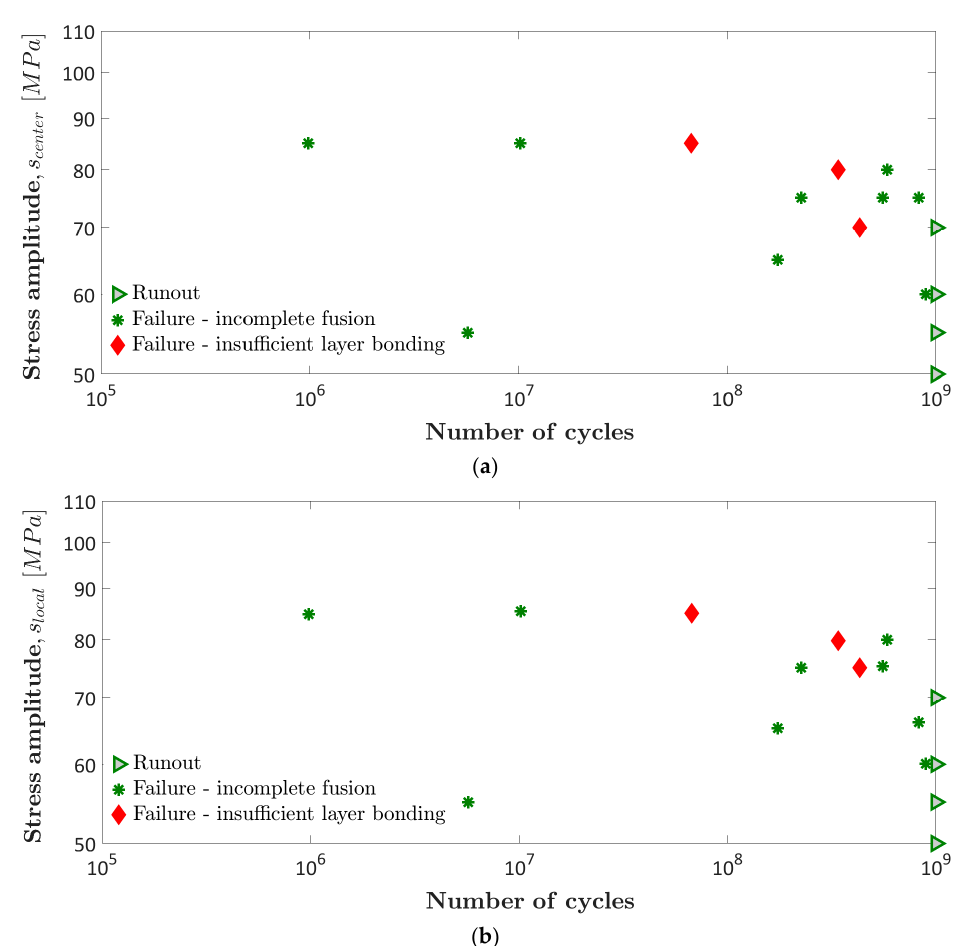
Figure 3. S-N plot of the experimental results: ( a ) s center with respect to N f ; ( b ) s local with respect to N f